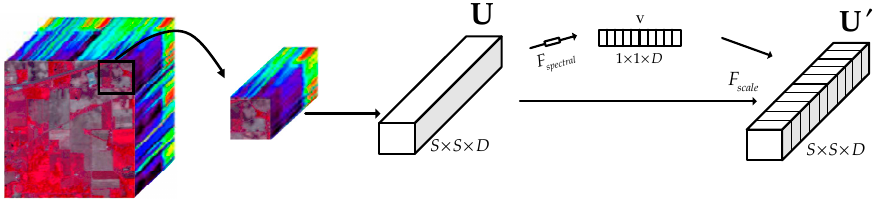
Figure 3. Basic structure of spectral-wise attention mechanism.